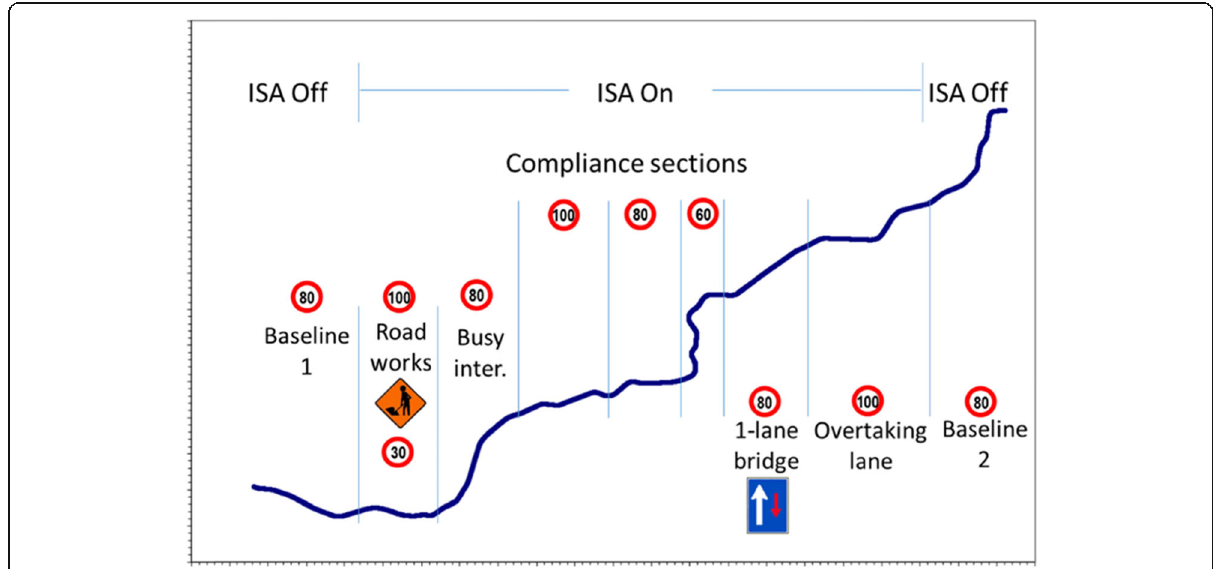
Fig. 2 Schematic map of the simulated road with speed limit sections and potential hazards